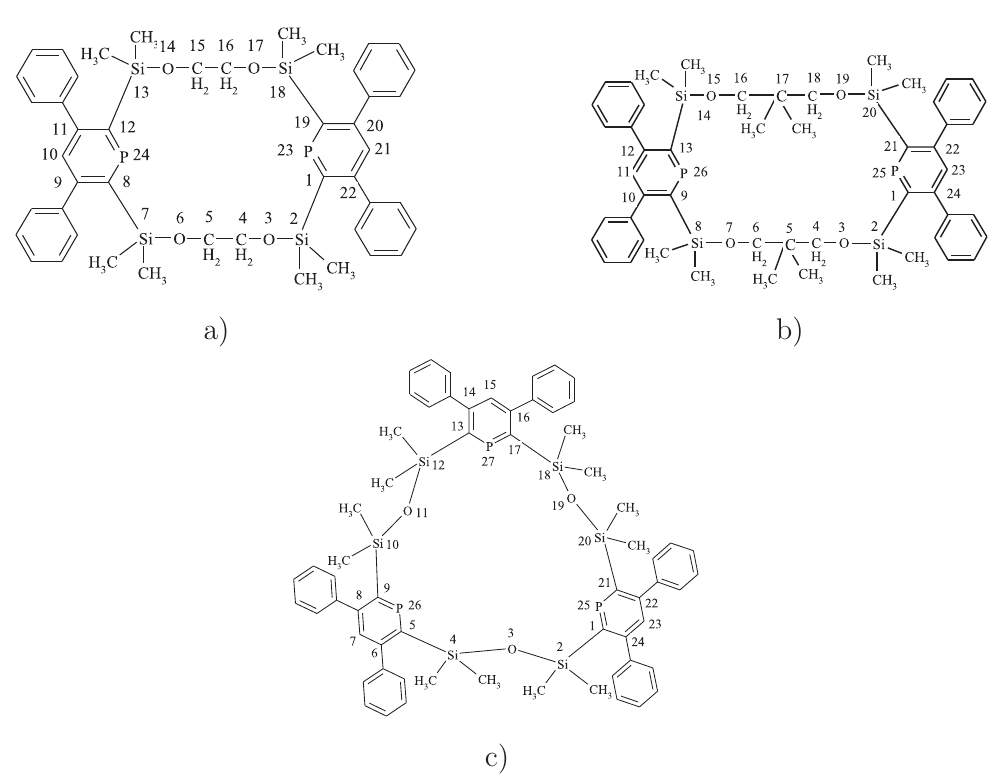
Fig. 1 Phosphinine-ether macrocycles,( a ) bis(dimethylsiloxy)-ethane-calix[2](3,5-diphenyl- phosphinine-2,6-diyl)- PE1 ;( b )bis(dimethylsiloxy)-2,2-dimethylpropane-calix[2](3,5-diphenyl- phosphinine-2,6-diyl)- PE2 ;( c )bis(dimethylsilyl)-oxa-calix[3](3,5- diphenylphosphinine-2,6-diyl)- ) - PE3